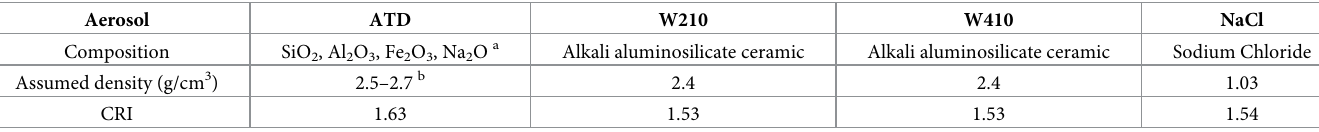
Table 1. Characteristics of the standard testing aerosols used in the study [52].